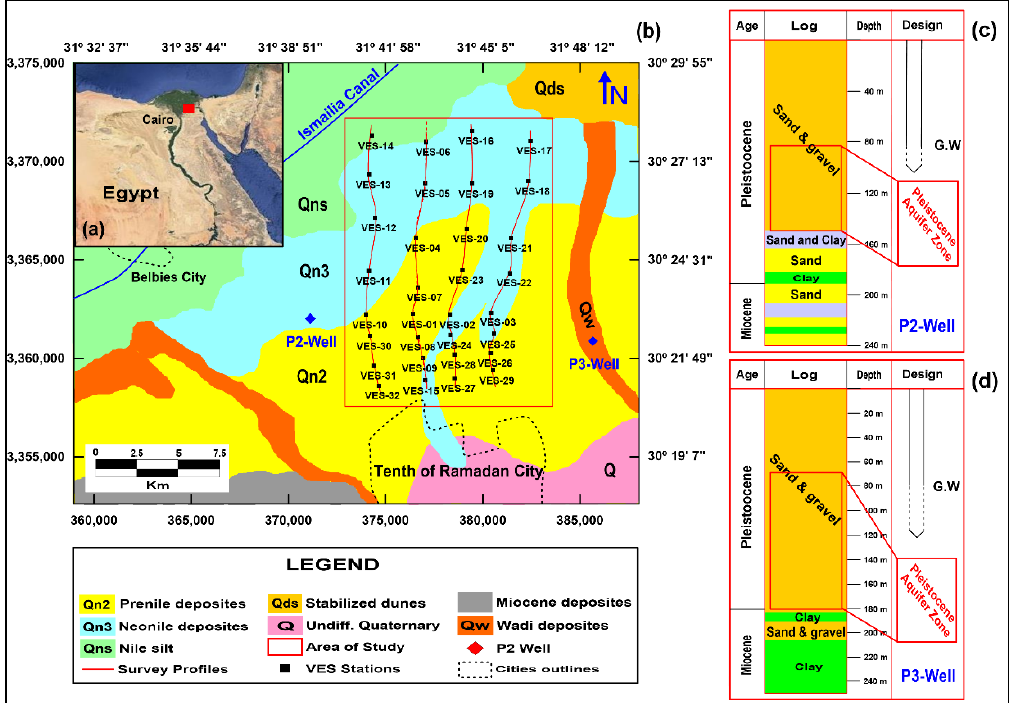
Figure 1. ( a ) Google map of Egypt, ( b ) Surface geological map of the study area and the location of the vertical electrical sounding (VES) stations along four main profiles, and ( c , d ) lithostratigraphic column of nearby boreholes from the study area (P2-Well and P3-Well).